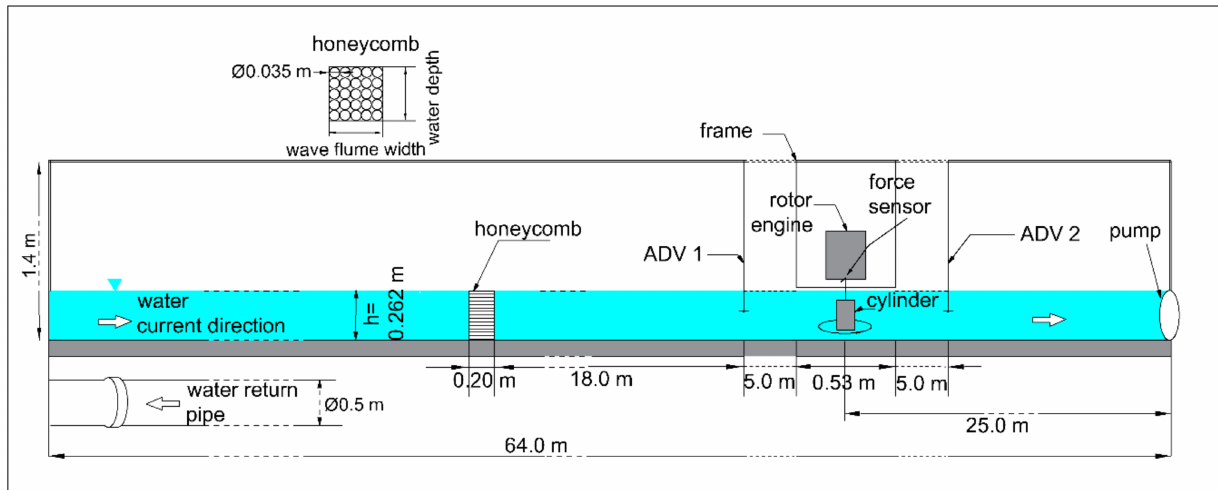
Figure 2. Scheme of the measurement